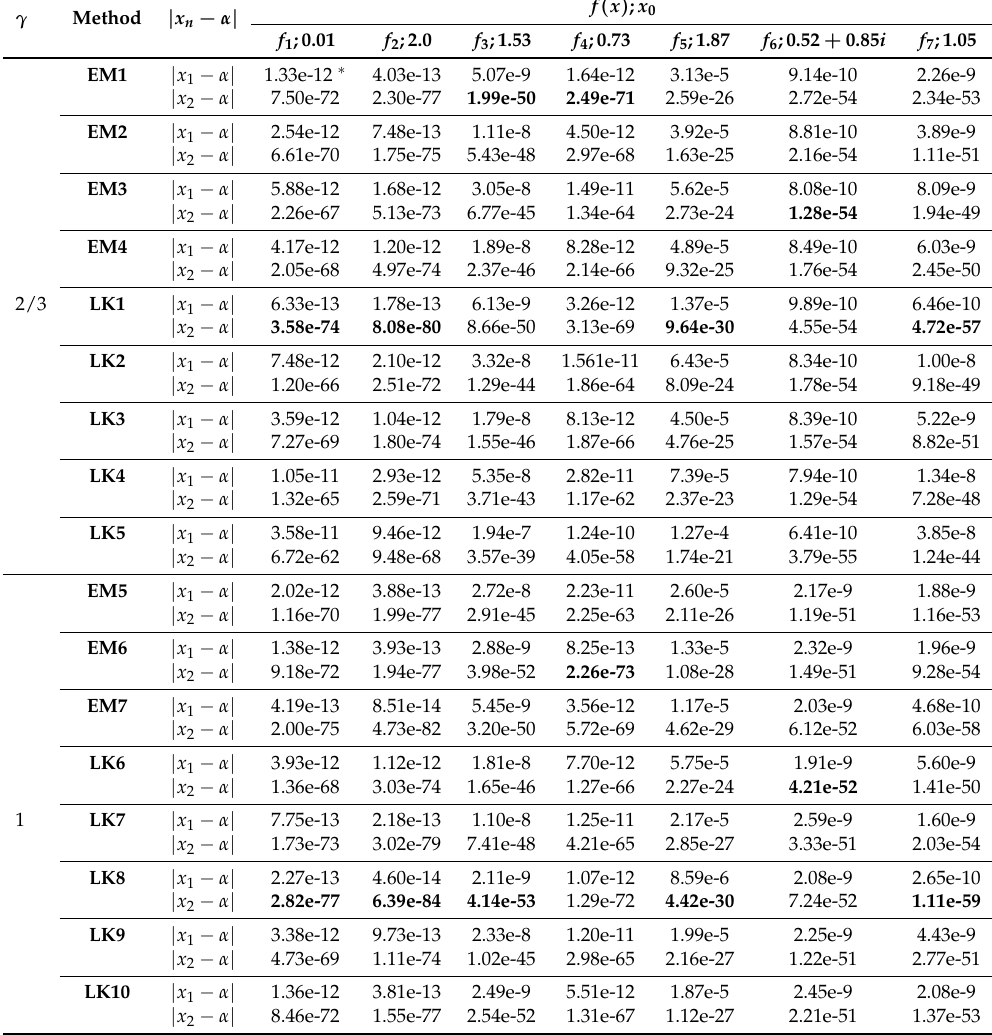
Table 3. Local convergence of selected methods for various test